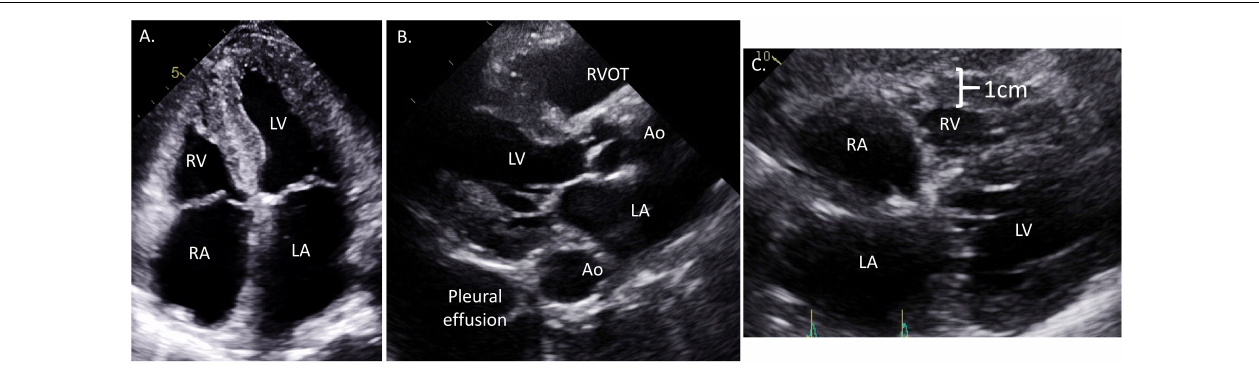
FIGURE 3 | Representative echocardiographic images from a patient with cardiac amyloidosis. (A) Apical 4-chamber view showing moderate concentric left ventricular hypertrophy with more prominent proximal septal hypertrophy, significant bi-atrial enlargement, and diffusely thickened atrioventricular valves. (B) Parasternal long axis view showing large pleural effusion, moderate concentric hypertrophy, small left ventricular end diastolic diameter (LVEDD), and right ventricle outflow track dilation. (C) Subcostal view demonstrating significant right ventricular hypertrophy, biatrial enlargement, and interatrial septal thickening.